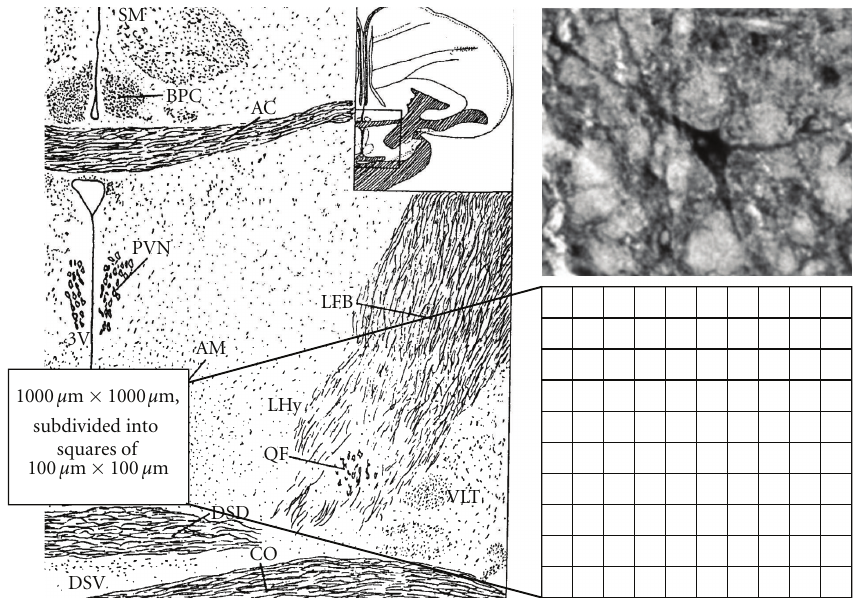
Figure 1: Left: anterior hypothalamus with the preoptic area after Kuenzel and Van Tienhoven [45], where the investigations were carried out (AC: Commissura anterior , PVN: Nuc. paraventricularis , 3V: third ventricle, AM: Nuc. anterior medialis hypothalami, CO: C hiasma opticum , LHy: lateral hypothalamic area, and FB: forebrain bundle). Right: typical examples of nNOS expression (magnification × 100) in a Muscovy duck embryo on E 23. nNOS positive Neurons were counted in a defined area, which was divided into 100 rectangles of 100 × 100 μ m.